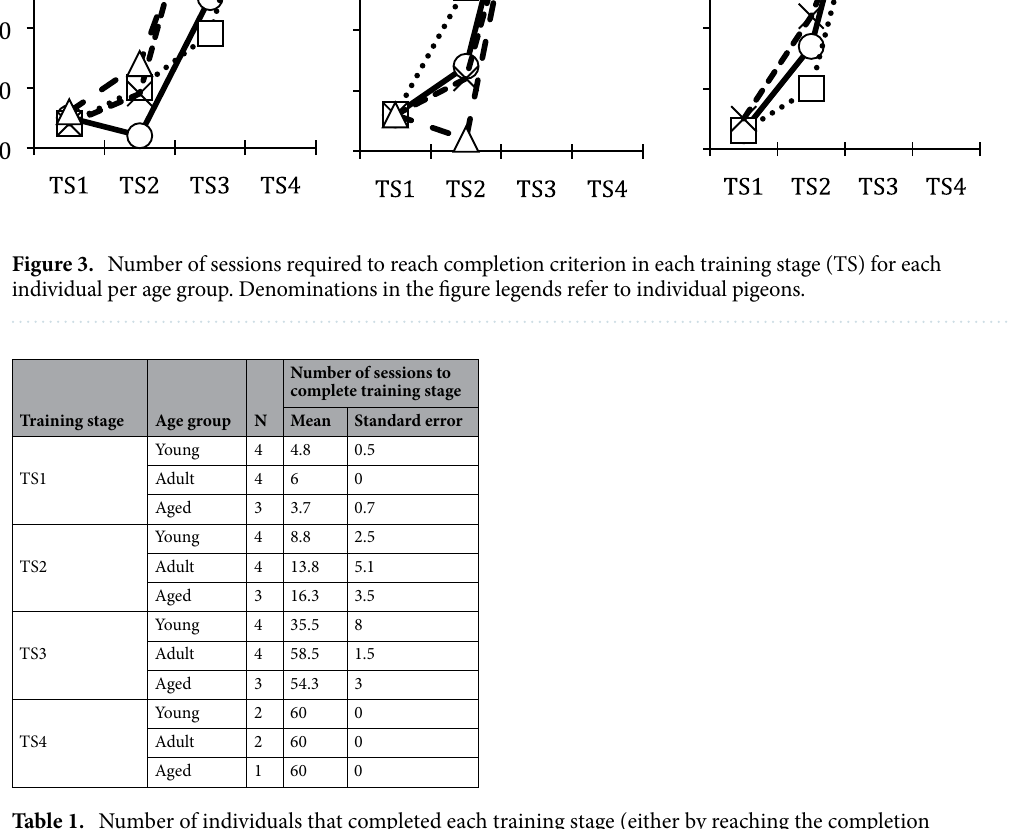
Table 1. Number of individuals that completed each training stage (either by reaching the completion criterion or by completing 60 sessions) and mean number of sessions required to complete each training stage.